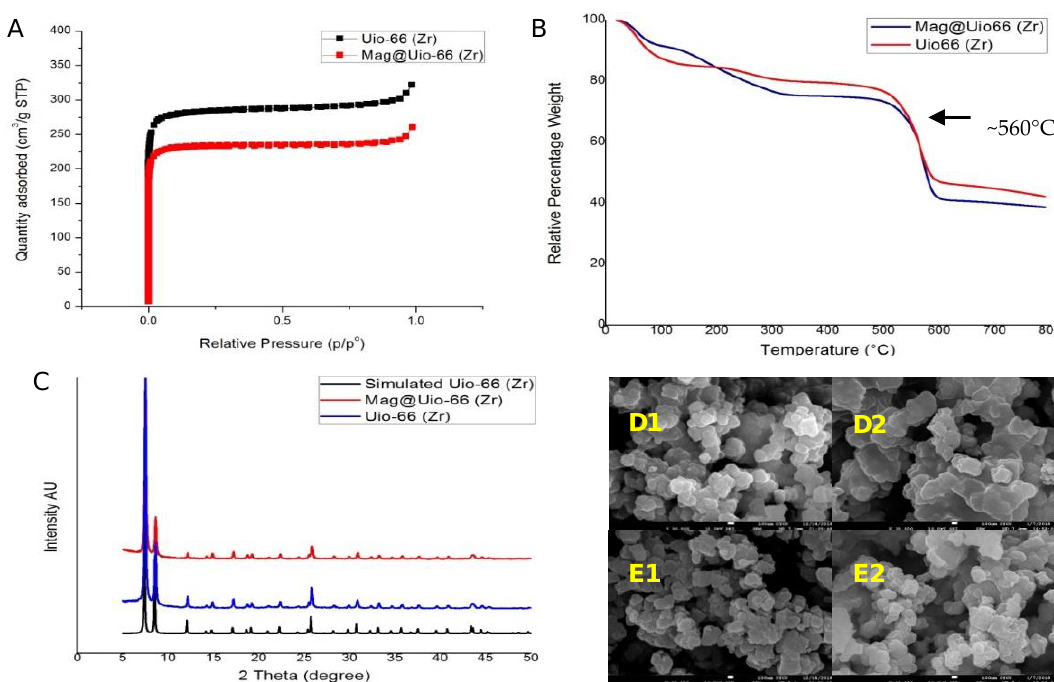
Figure 3. Characterization of pure Uio-66(Zr) and mag@Uio-66(Zr) after 36 h. ( A ) nitrogen adsorption–desorption plot, ( B ) thermogram plot, ( C ) XRD pattern, ( D1 – 2 ) micropictograph of pristine Uio-66(Zr) at 30,000×, and ( E1 – 2 ) micropictograph of mag@Uio-66(Zr) at 30,000×.